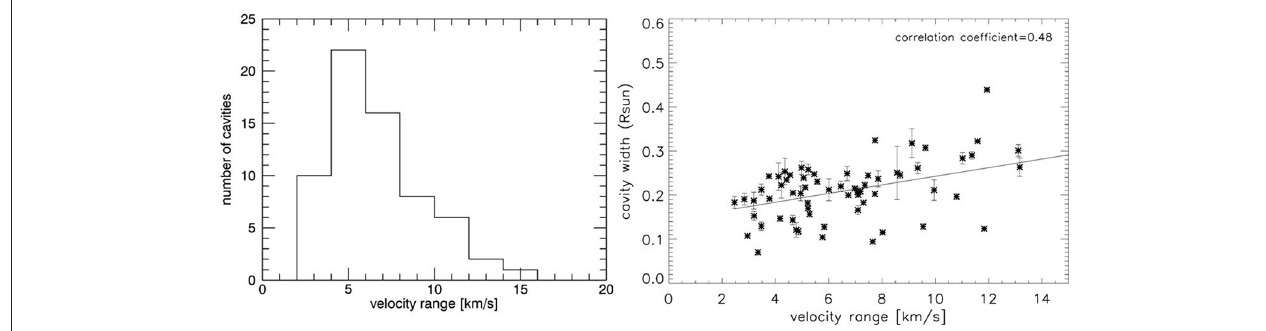
FIGURE 6 | Left: Histogram of velocity ranges, Right: Relation between velocity range and cavity width. Correlation coefficient is equal to 0.48.